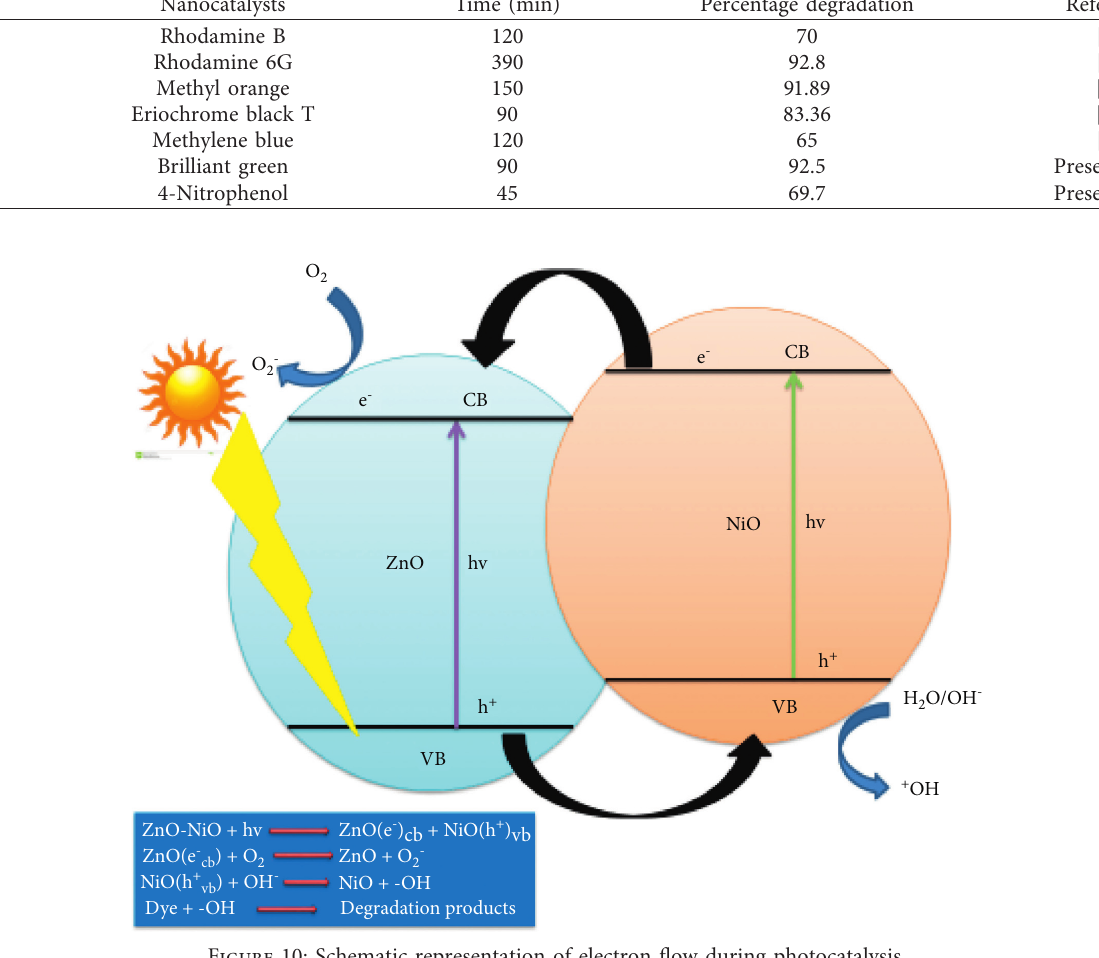
Figure 9: (a) Absorption spectra of 4-nitrophenol. (b) Degradation profile, (c) percent degradation, and (d) kinetic isotherm. Table 1: The photocatalytic efficacy of NiO-ZnO NC against different organic pollutants. S. no.